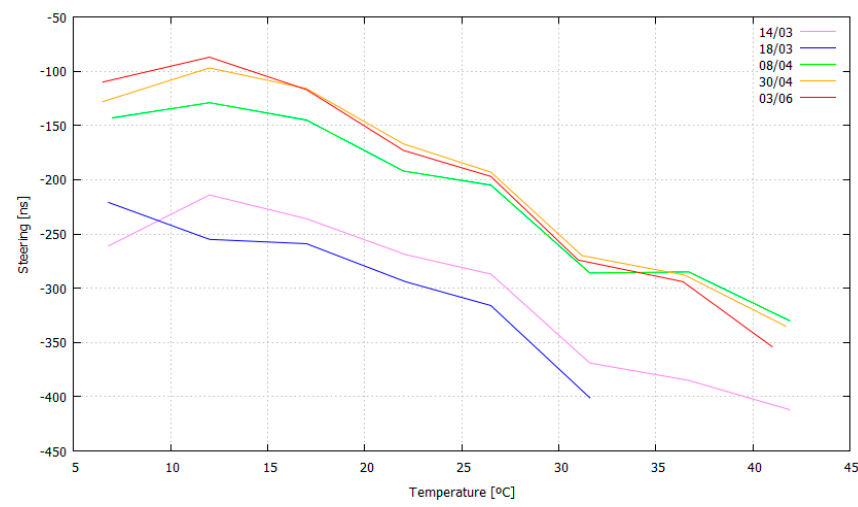
Figure 11. Steering values ( y -axis) vs. temperature ( x -axis) on long term (coloured labels).